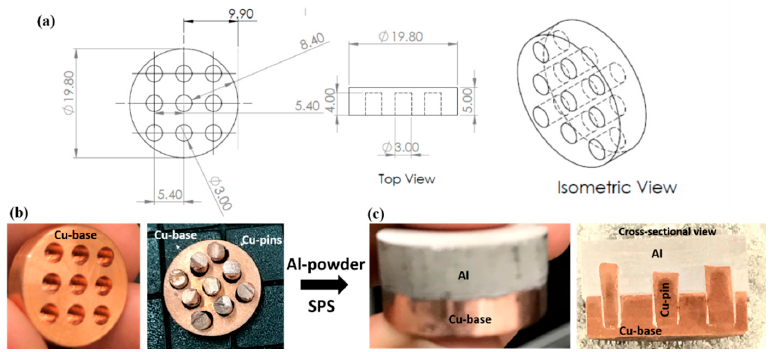
Figure 6. Complex hybrid structure of Cu rod -Cu pins -Al powder ( a ) CAD design, ( b , c ) overall steps involved in machining, assembling, and SPS. The cross-sectional view of the complex and dense hybrid structure of Cu rod -Cu pins -Al has also been presented in ( c ).